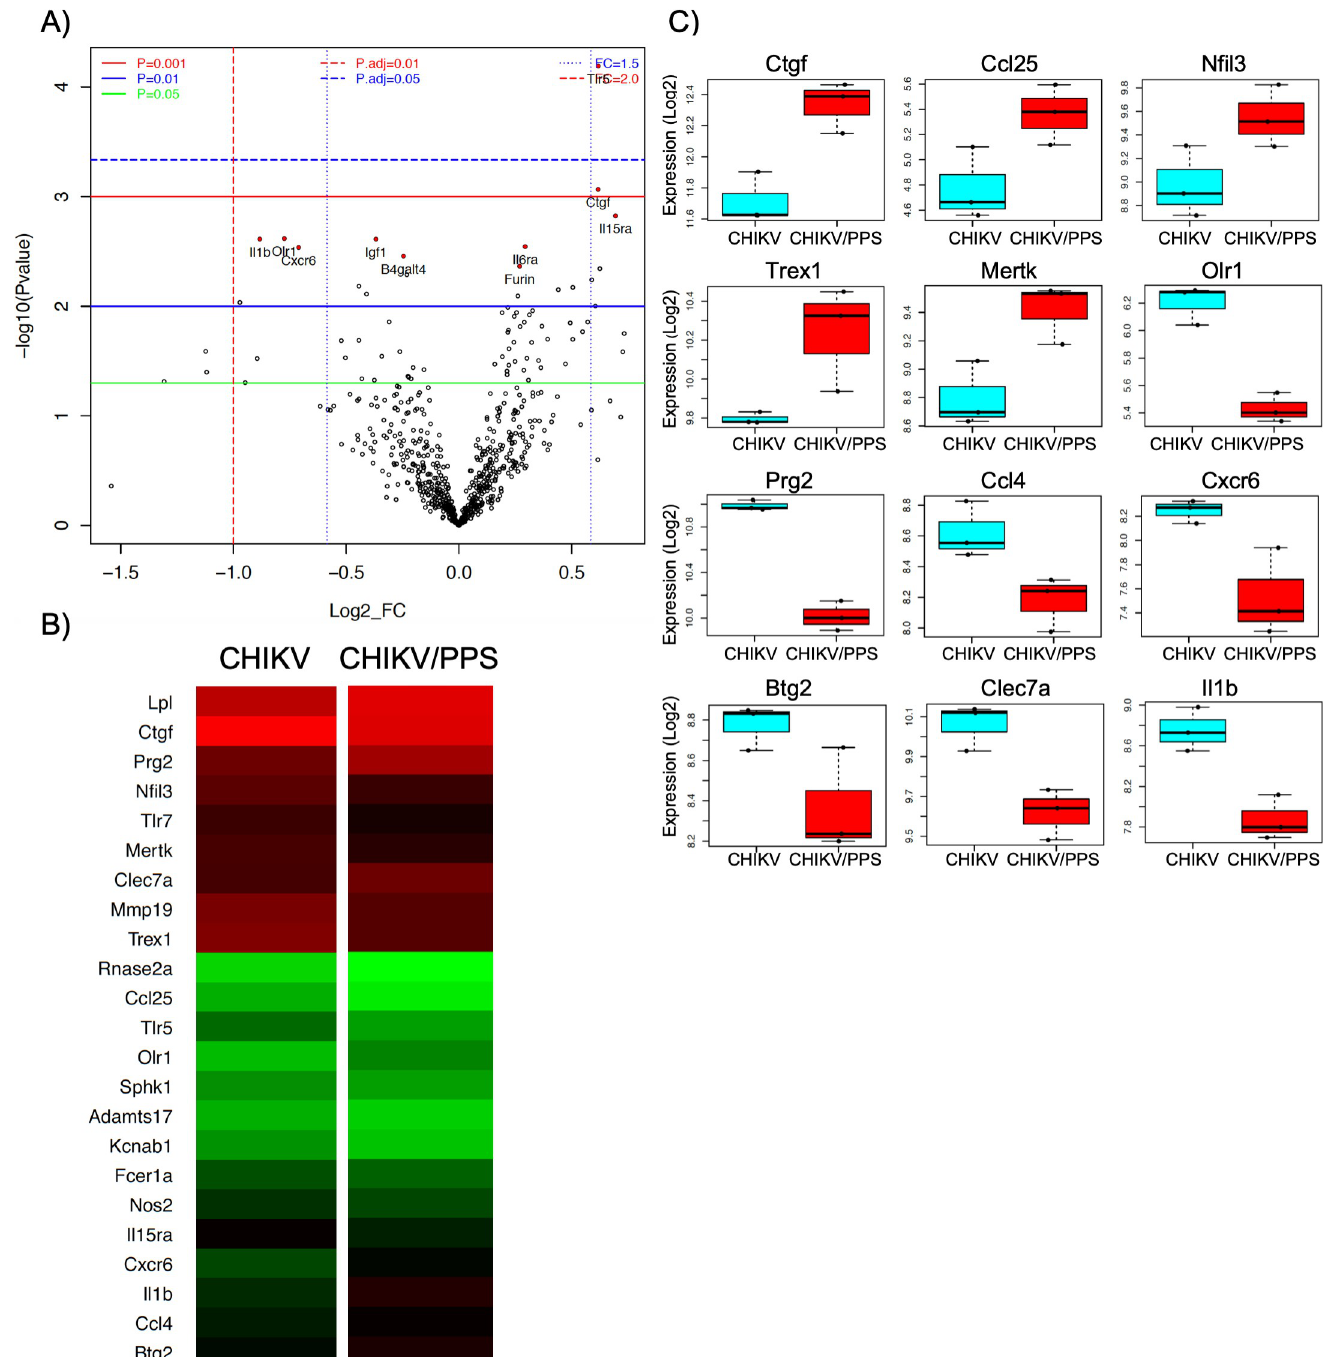
Fig 5. qPCR NanoString ™ panel and bioinformatic analysis of joint tissue. Gene expression analysis of RNA isolated from joint tissue at peak disease was performed using the commercially available NanoString ™ nCounter 1 mouse Myeloid Innate Immunity gene expression panel. Data shows (A) volcano plots, (B) heat maps and (C) box plots (Log2) of key genes that are modulated in mouse joints during PPS treatment. Gene expression data was analysed using Limma package and P values were adjusted for multiple testing by Benjamini and Hochberg method to control the false discovery rate. Data compares tissues from CHIKV-infected PPS-treated mice to CHIKV-infected untreated mice (n = 3 mice/group). Top genes chosen had a FC > 1.3 or FC < -1.3 and a P value < 0.02.